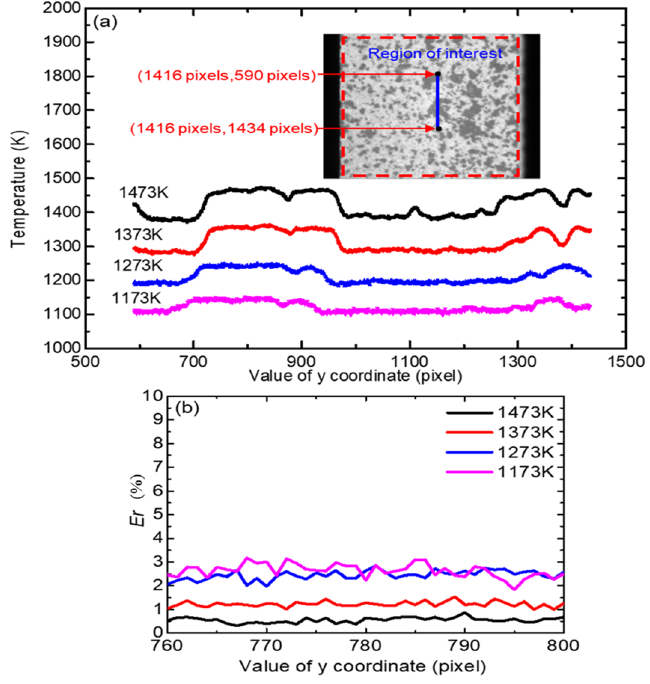
Figure 10. Typical temperature variation with coordinate changing for a randomly selected line in the region of interest ( a ) and the relative error Er. at different temperatures ( b ).